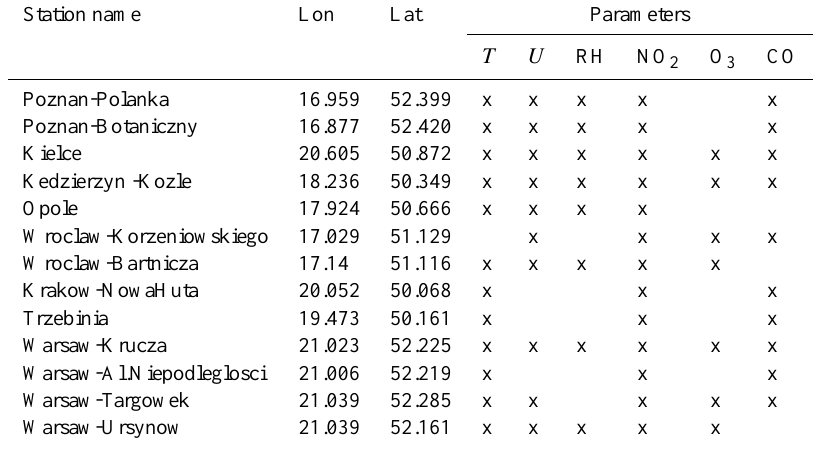
Table 2. Location and characteristics of monitoring sites and parameters observed (usually the data were not available for all analysed days). Station